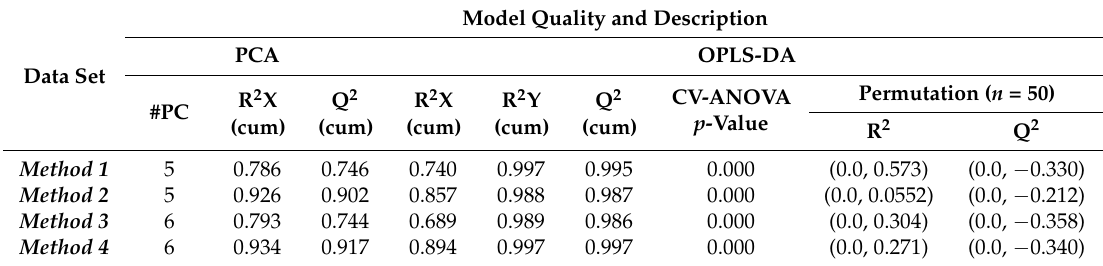
Table 2. Generated PCA and OPLS-DA models of the four dataset matrices described as Methods 1–4 (Section